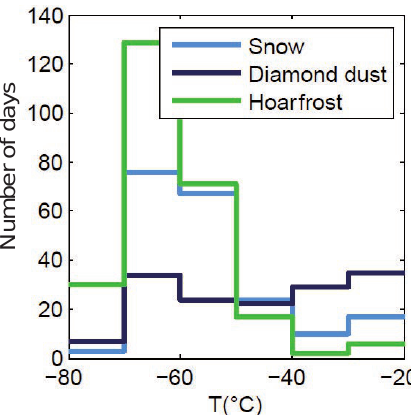
Figure 2. Frequency of the different precipitation types of observed precipitation.